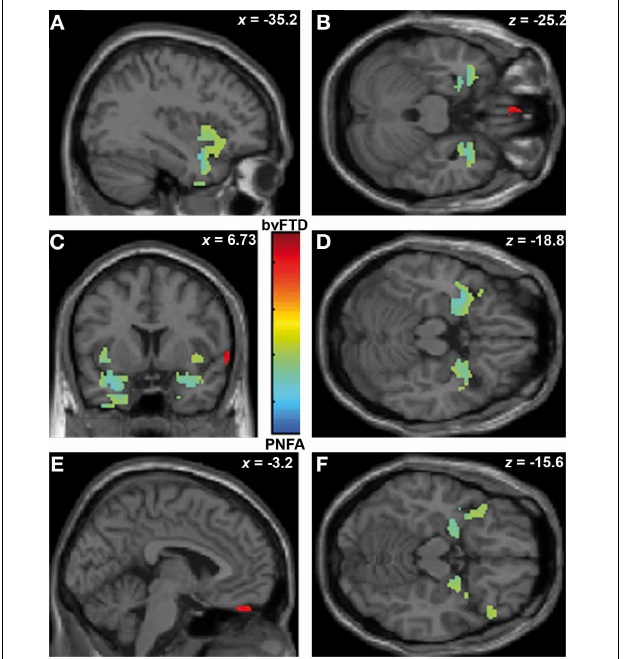
FIGURE 4 | Contrast vectors of bvFTD (red-yellow) and PNFA (light blue) atrophy correlated with emotion recognition. p < 0 . 05, small volume corrected. (A) Right insular and temporal correlations; (B,D,F) Orbitofrontal and mid temporal regions; (C) Bilateral insular correlations of PNFA emotions; (E) Right gyrus rectus for bvFTD. PNFA, progressive non-fluid aphasia, bvFTD, behavioral variant FTD.